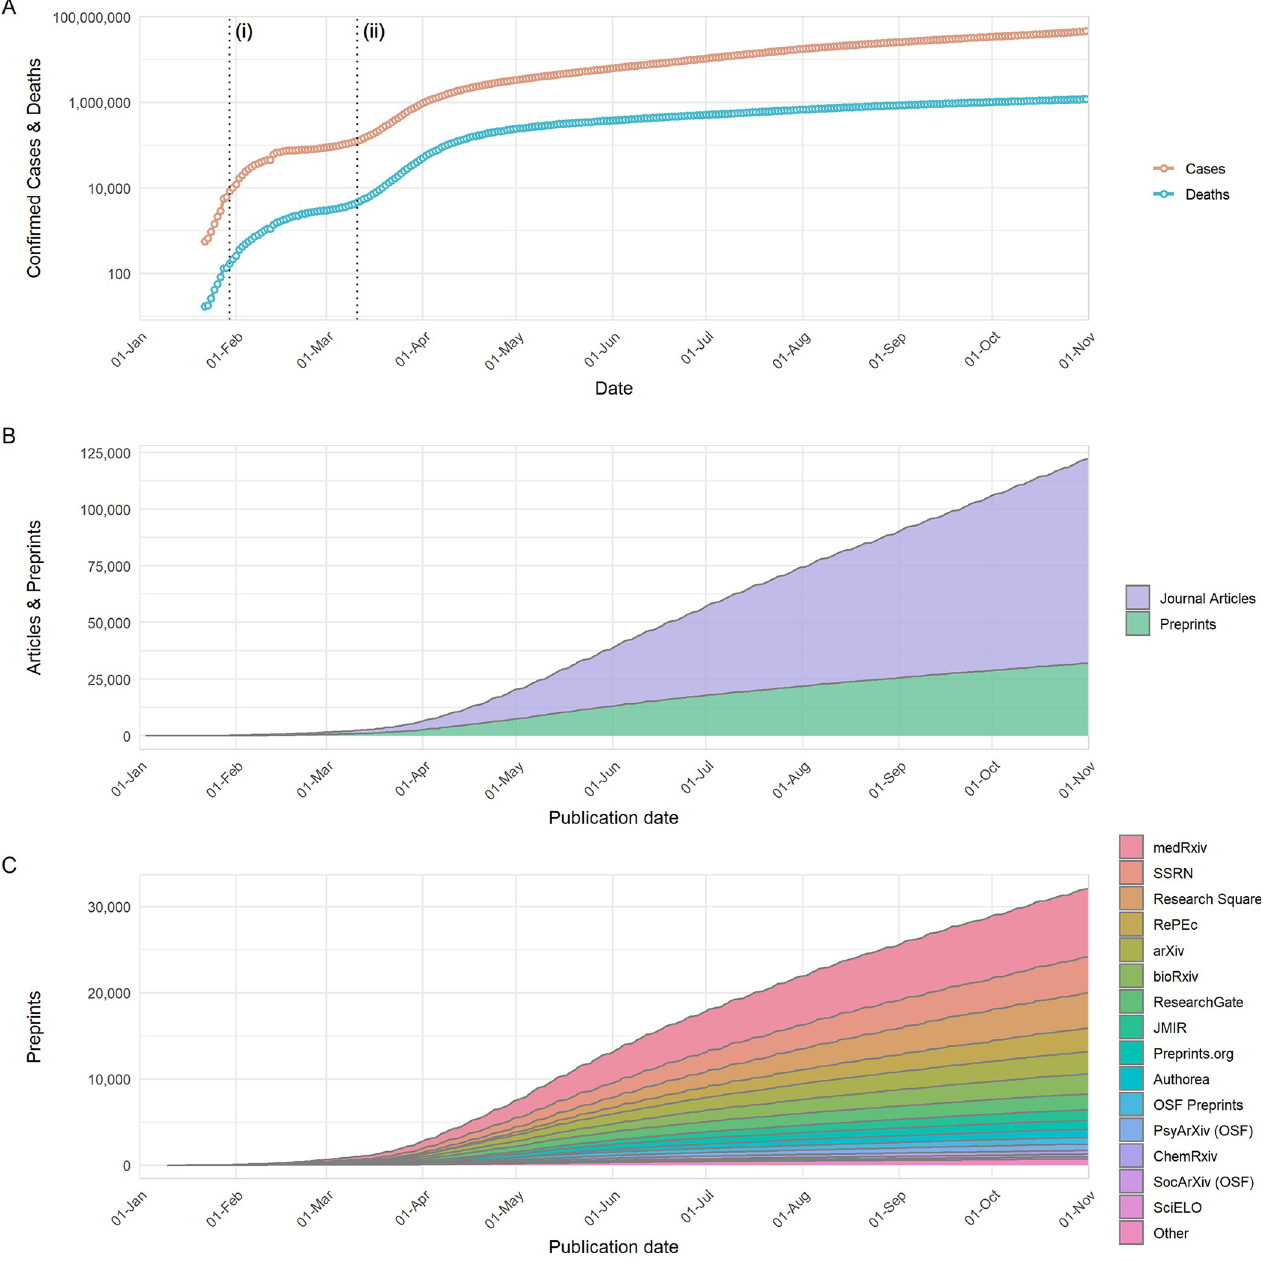
Fig 1. Development of COVID-19 and publication response from January 1 to October 31, 2020. (A) Number of COVID-19 confirmed cases and reported deaths. Data are sourced from https://github.com/datasets/covid-19/, based on case and death data aggregated by the Johns Hopkins University Center for Systems Science and Engineering (https://systems.jhu.edu/). Vertical lines labelled (i) and (ii) refer to the date on which the WHO declared COVID-19 outbreak a Public Health Emergency of International Concern, and the date on which the WHO declared the COVID-19 outbreak to be a pandemic, respectively. (B) Cumulative growth of journal articles and preprints containing COVID-19–related search terms. (C) Cumulative growth of preprints containing COVID-19–related search terms, categorised by individual preprint servers. Journal article data in (B) are based upon data extracted from Dimensions (https://www.dimensions.ai; see Methods section for further details), and preprint data in (B) and (C) are based upon data gathered by Fraser and Kramer (2020). The data underlying this figure may be found in https://github.com/preprinting-a-pandemic/pandemic_preprints and https://zenodo.org/ record/4587214#.YEN22Hmnx9A. COVID-19, Coronavirus Disease 2019; WHO, World Health Organization.